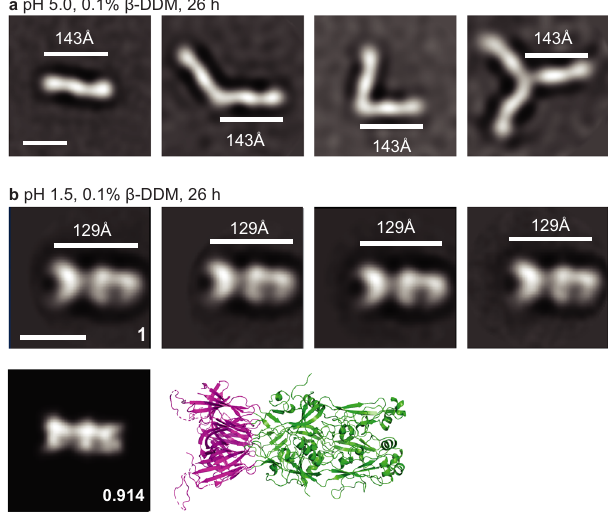
Fig. 7 Intermediate and postfusion states of Cyani HAP2 D1D2 fragment. a Representative class average of Cyani HAP2 D1D2 at pH 5.0 in 0.1% β - DDM after 26 h at 37 °C. b Representative class averages of Cyani HAP2 D1D2 at pH 1.5 in 0.1% β -DDM after 26 h at 37 °C. The length of particles (white lines) was measured. Scale bars of 10 nm are shown in the left-most class average. The best cross-correlating crystal structure projection and the cross-correlation coef fi cient are shown below one class average and the corresponding crystal structure as an enlarged ribbon diagram. Complete class averages are shown in Supplementary Fig. 5. The experiments of a , b were repeated twice with similar